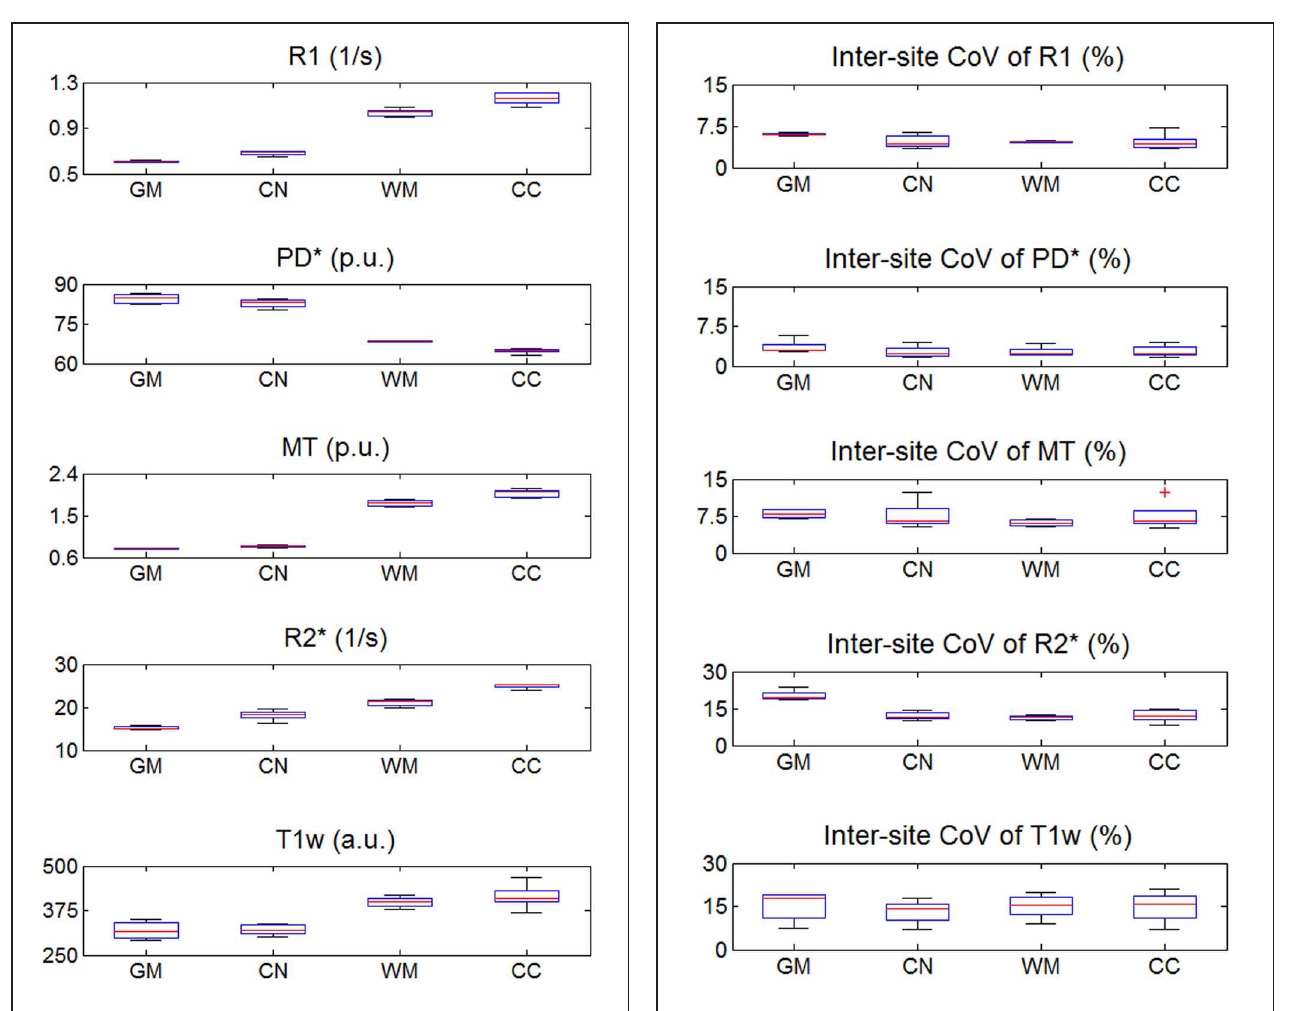
FIGURE 2 | R1, PD ∗ , MT, and R2 ∗ parameter and T1w image intensity values averaged across the three different sites. Values were determined separately for gray matter (GM), head of the caudate nucleus (CN), white matter (WM) and genu of the corpus callosum (CC). The distribution across volunteers is depicted as a whisker plot: blue box = 25/75% percentile; red line, median, black whisker, most extreme data value excluding outliers; red cross, outlier (probability < 0.01 under assumption of normally distributed data).